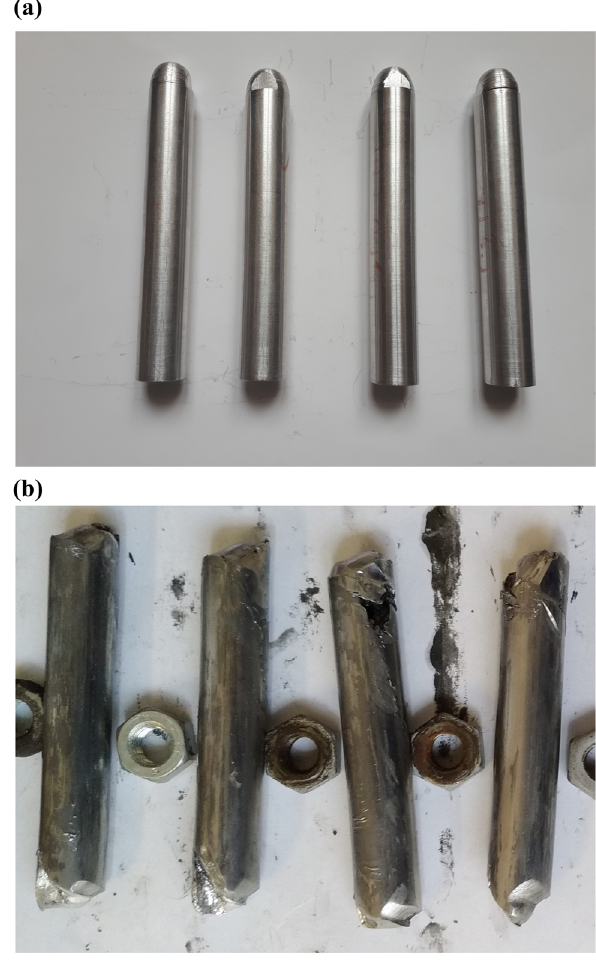
Figure 2: Photographs taken on the capsules ( a ) before and ( b ) after the ECAP